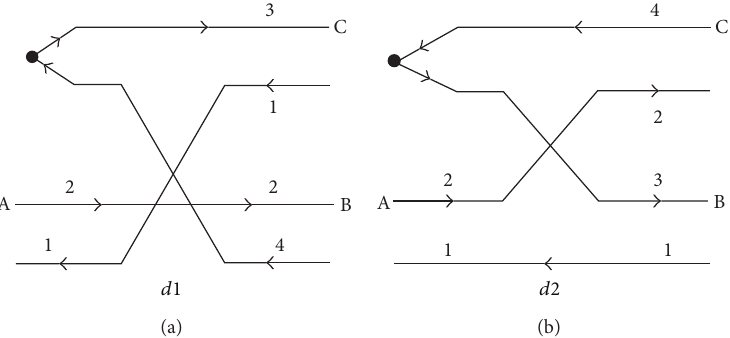
Figure 6: Two topological diagrams for a 𝑞𝑞 meson decay in the 3 𝑃 0 decay model. We refer to the left one as 𝑑1 where the produced quark goes into meson 𝐶 and 𝑑2 where it goes into 𝐵 .